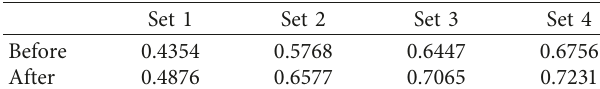
Table 3: Comparison of results of different data set before and after using optimization (data set 3).